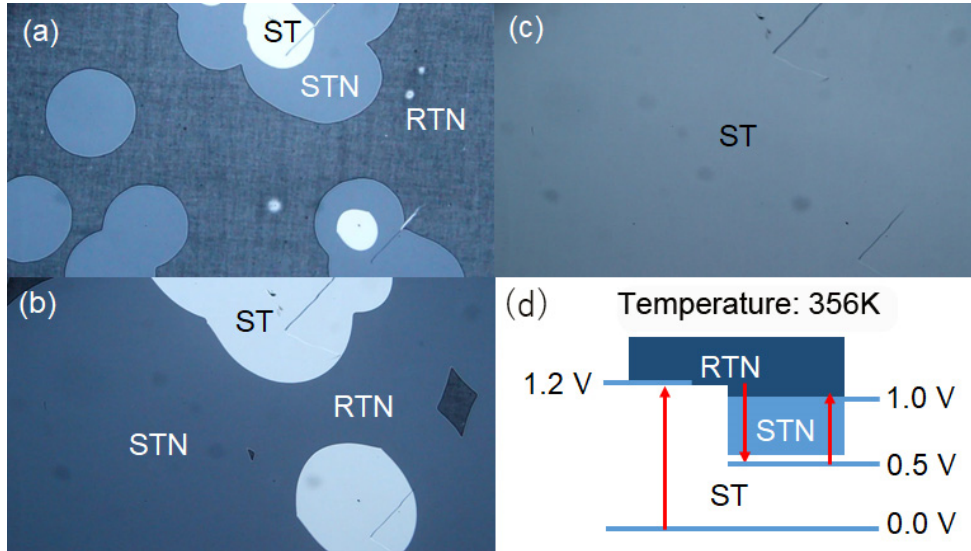
Figure 4. POM images acquired at 356 K; ( a ) immediately after changing the applied voltage from 1.2 to 0.5 V, ( b ) after a short time, and ( c ) after a relatively long time. ( a ) The structure changed from RTN to STN or ST. ( b ) The transition speed to STN was faster than that to ST. At this time, increasing the applied voltage to 1.0 V results in transition of the STN structure to the RTN structure, while the ST structure is maintained. ( c ) After a relatively long time of applying a voltage lower than 1.0 V, the structure eventually becomes the ST structure. ( d ) The ST structure changed to the RTN structure with application of 1.2 V at 356 K. A decrease in the voltage to 0.5 or 0 V resulted in a transition of the RTN structure to the ST structure via the STN state. The STN structure changed to the RTN structure with application of 1.0 V at 356 K.